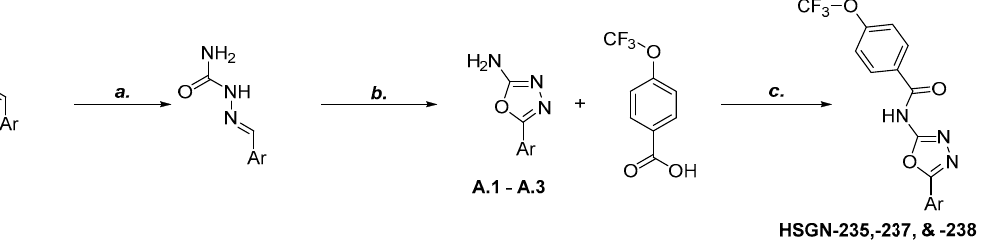
Scheme 1. Synthesis of N-(1,3,4-oxadiazol-2-yl)benzamides. Reagents and Conditions: ( a )